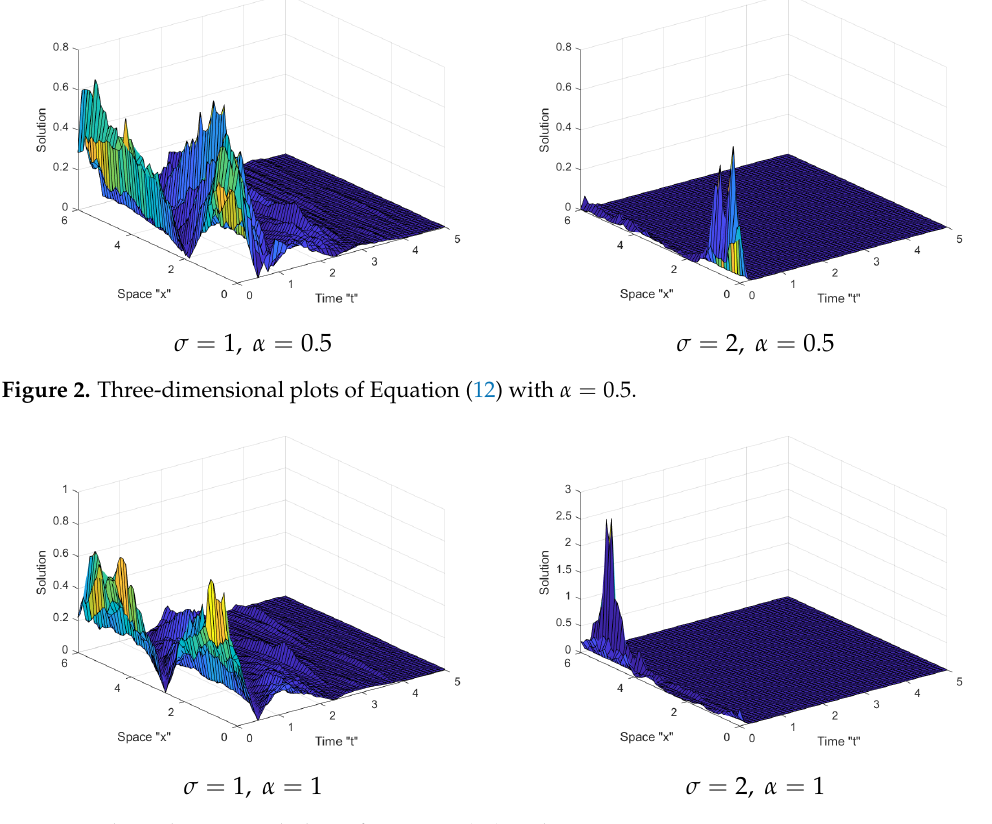
Figure 3. Three-dimensional plots of Equation (12) with α =